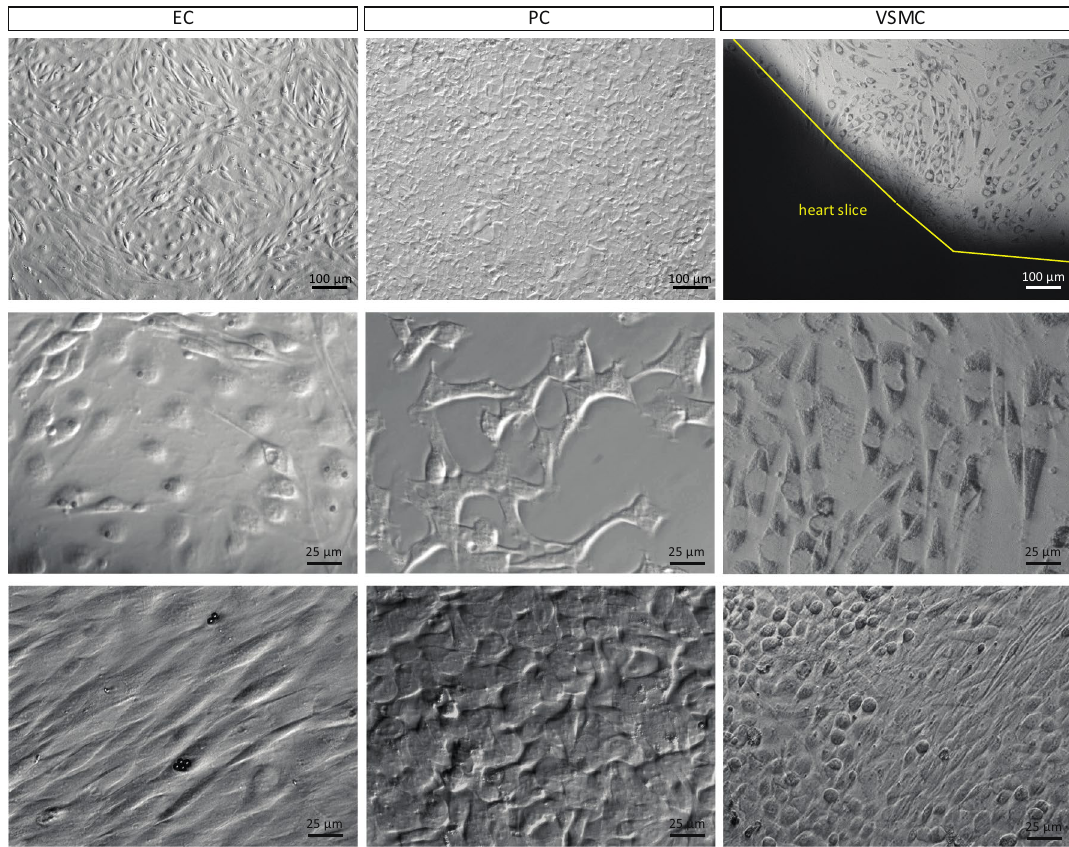
Figure 2. Morphology of cultured ECs, PCs, and VSMCs. Top row: low magnification phase-contrast images of cells, note the typical cobble-stone appearance of the confluent EC culture. Scale bar, 100 µm. Middle row: sub-confluent cultures, with pericytes displaying their characteristic polygonal shape, scale bar 25 µm. Bottom row: high magnification images of confluent cultures; ECs form a uniform monolayer (Dynabeads still present on some cells), PCs maintain their polygonal shape, and VSMCs generate a culture of mixed round and spindle- shape morphology, scale bar 25 Having established the cell isolation protocol and confirmed cell identities by immunocytochemistry (ICC), we then analyzed each cell type using tandem mass tag (TMT) quantitative proteomics. Figure 4A is principal component analysis (PCA) visualization, showing clear separation between the three cell types, with 3 independ- ent samples representing each cell type overlapping or located very closely to each other. Figure 4B shows levels of cell-specific proteins in the different cell types, further confirming cell identities and validating our cell isola- tion protocol. Specifically, our analysis shows that levels of the endothelial marker CD31 (PECAM1) is higher in ECs than in other cells, the pericyte marker PDGFRβ was higher in PCs than other cells types, and α-SMA (ACTA2) and calponin (CNN1) were higher in VSMCs compared to the other cells. We also compiled the top 50 most abundant proteins and transcripts, illustrate overlap and carried out Gene Ontology (GO) term analysis, for each cell type (Supplemental Table S1, Supplemental Figs. S1 and S2) after performing bulk RNA sequencing of each cell type using the same isolation and culture methods. The RNA sequencing data have been deposited to GEO with the series number GSE190809. [The data is available for reviewers with token gnefuwiafzwnvcz]. Overall, 4694 proteins were detected in all three cell types (Supplemental Table S2). Setting a threshold for differentially expressed (DE) proteins at abs(logFC) > 0.5 and hypothesis test FDR < 0.05, pairwise comparisons identified 2834 DE proteins between VSMCs and PCs, 2631 between PCs and ECs, and 1814 between VSMCs and ECs (Fig. 5A). These differences can be visualized in the volcano plots in Fig. 5B, which display statistical significance ( − log 10 p-values; y-axis) versus magnitude of change (Log 2 FC). Five proteins with highest fold change and statistical significance are highlighted in orange and labelled in each comparison. The top DE proteins